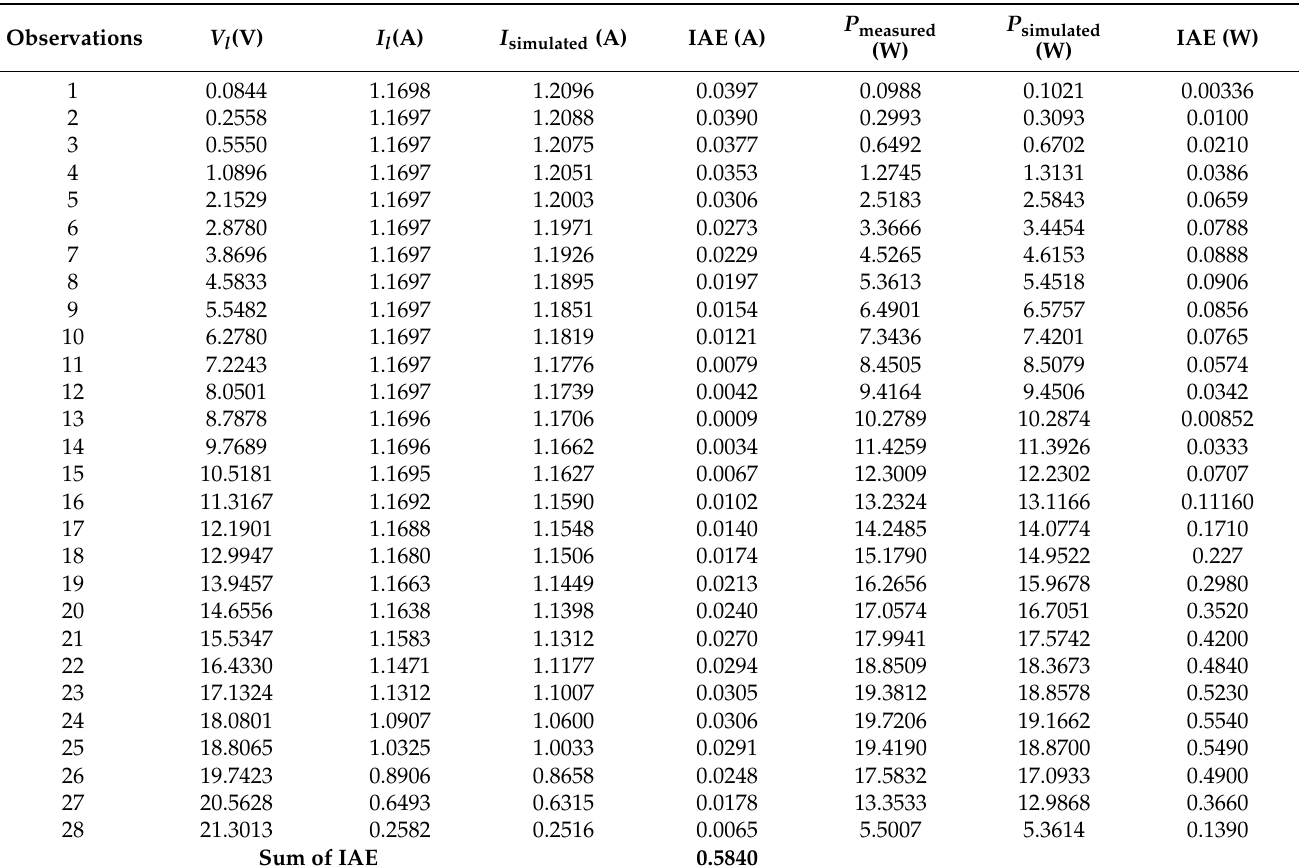
Table 4. The simulated current and absolute error results of the STO for SDM of the SS2018 PV module.